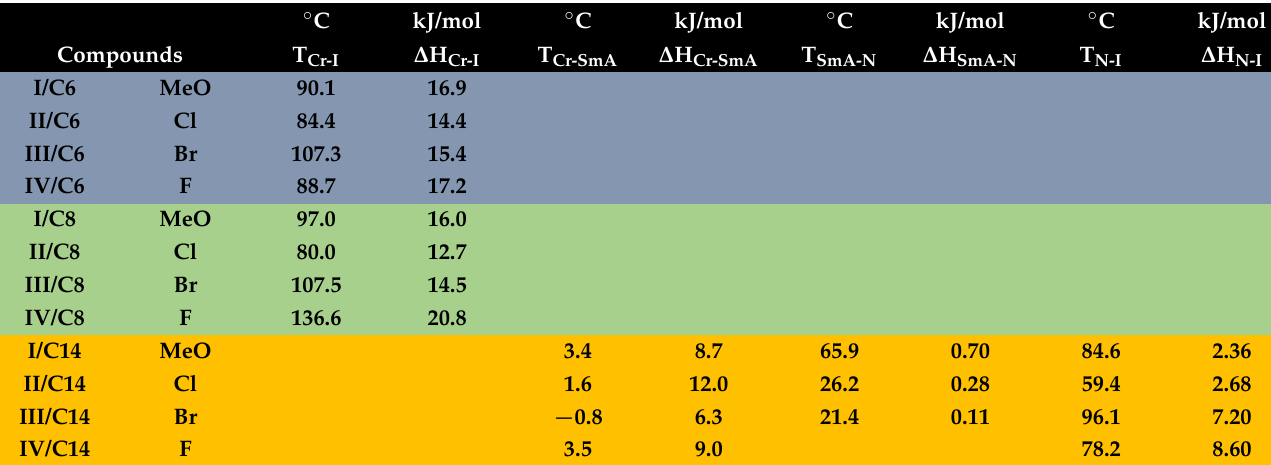
Table 1. Phase transitions: temperatures (T, °C) and enthalpies ( ∆H , kJ/mol) for the ((I-IV)Cn) functionalized ionic liquids. The abbreviations Cr-I, Cr-SmA, SmA-N and N-I denote the crystalline to isotropic, crystalline to smectic A, smectic A to nematic and nematic to isotropic transitions, re-